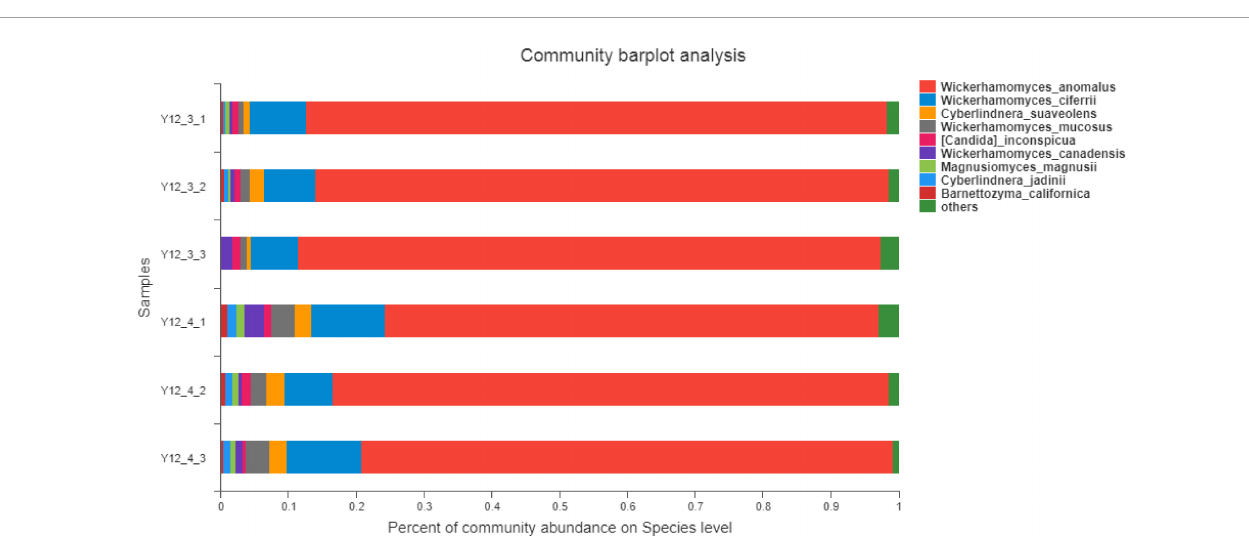
FIGURE10 Community abundance at species level of fungi in fermented